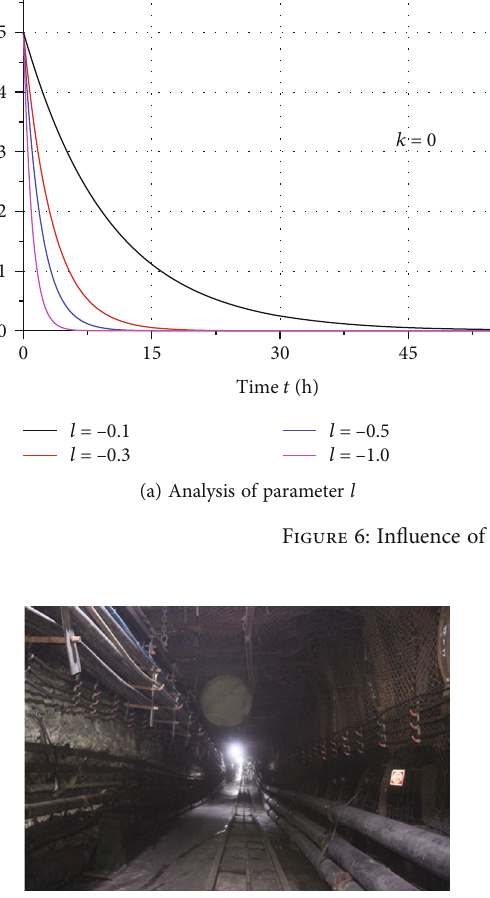
Figure 7: Basic condition of